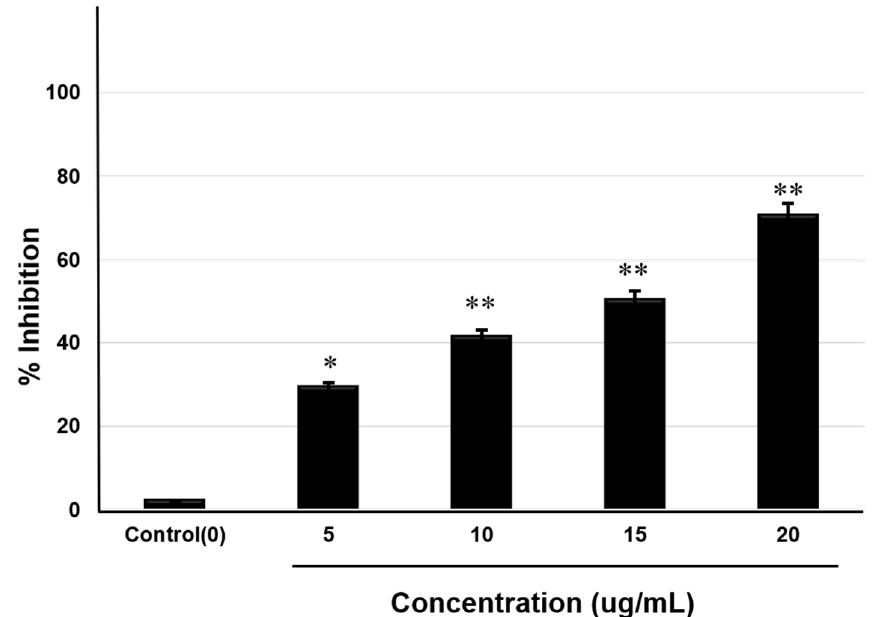
Figure 4. Acetylcholinesterase inhibitory activity of theasaponin E1. Percent inhibition was measured for each concentration and control according to the manufacturer’s protocol. Data are expressed as mean ± SEM. Data were analysed with one-way ANOVA ( n = 3). Data are statistically significant at p < 0.05. (* represents significance at p < 0.05, ** represents significance at p < 0.01).